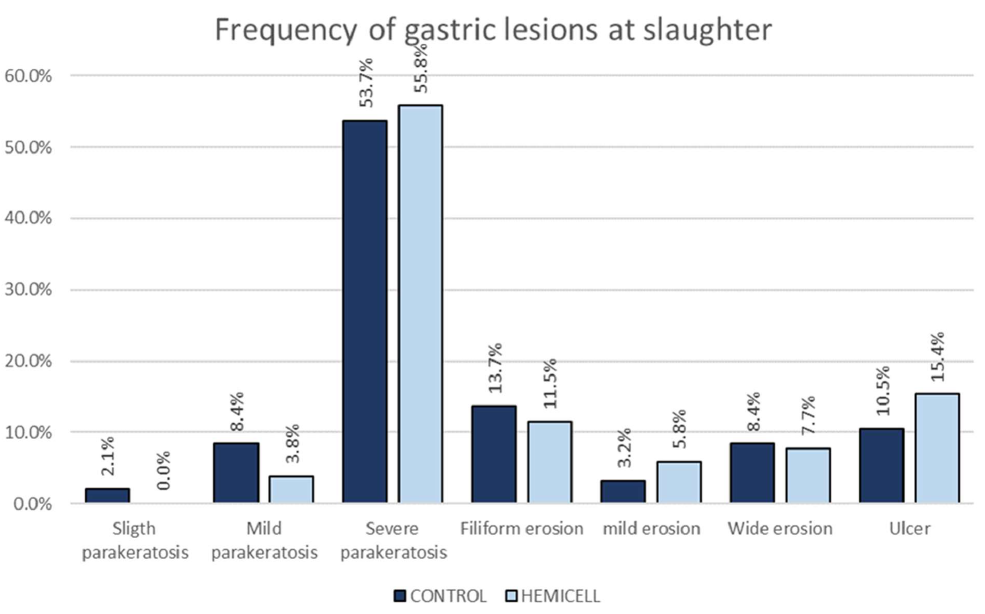
The correlations among biomarkers quantifications and physical performances are shown in Tables 7 and 8.